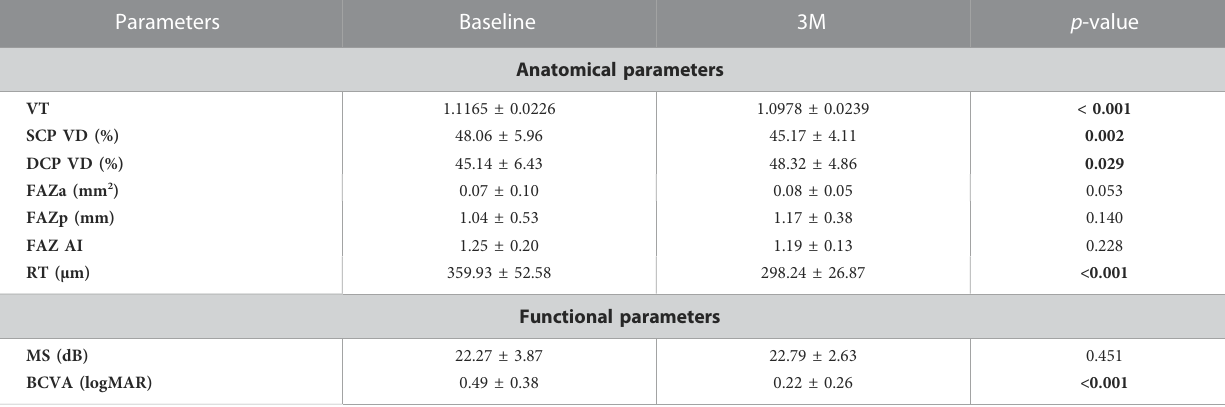
TABLE 2 Comparison of functional and anatomical parameters of the macular region at baseline and 3 months (3M) after surgery in eyes with iERM.